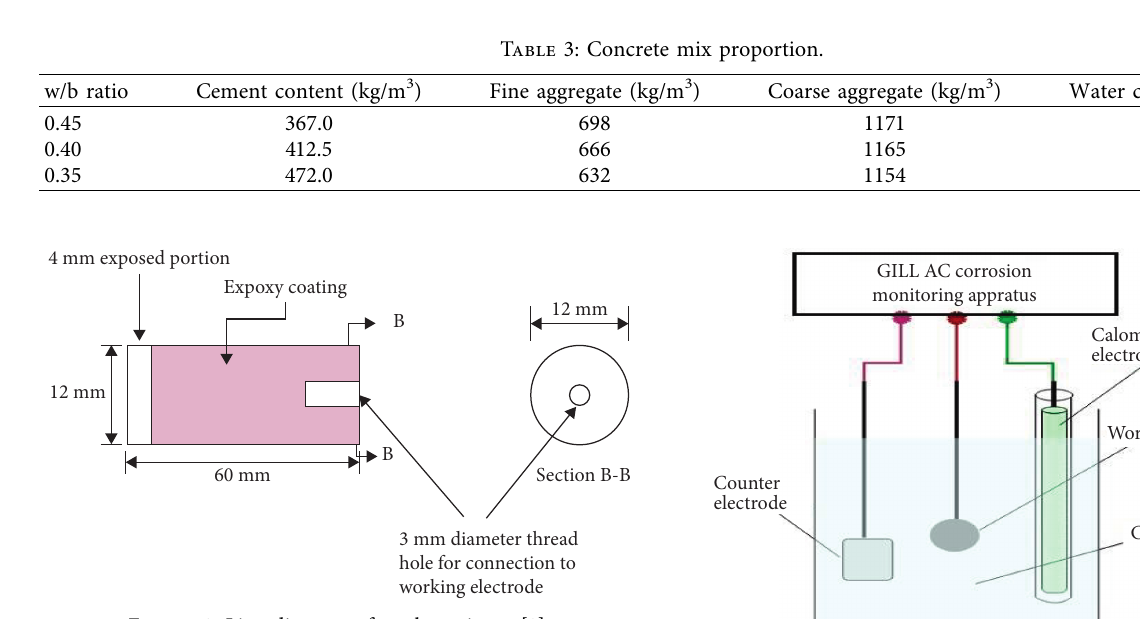
Figure 1: Line diagram of steel specimen [1].